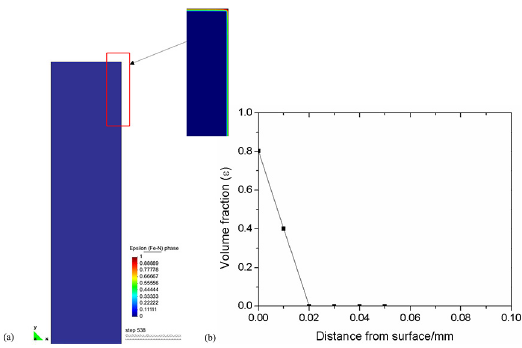
Figure 6. Simulated ε iron nitride results by COSMAP.